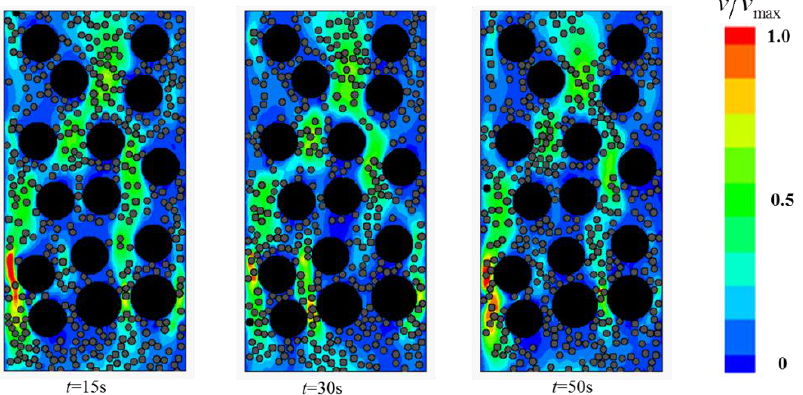
Figure 14. The flow field at different times with 4 narrow channels.